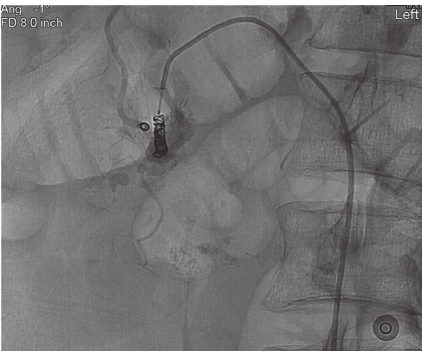
Figure 7: Multiple coils delivered at the side of the pseudoa- neurysm during